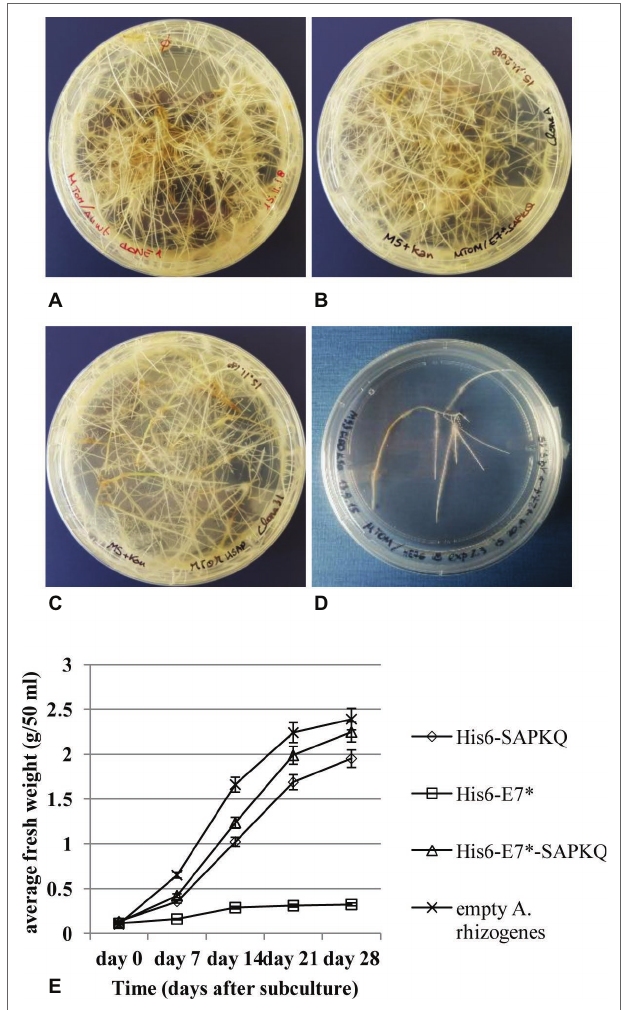
FIGURE 3 | Micro-Tom ( S. lycopersicum ) clonal hairy root lines obtained after (A) transformation with empty A. rhizogenes A4, (B) expressing the recombinant His 6 -E7*-SAPKQ, (C) His 6 -SAPKQ, or (D) His 6 -E7*. (E) Growth rate of one representative clone for each transformation was measured as root fresh weight at different time points after subculture over a 28-day period. Data represent average values ± SD of triplicate assays from two biological